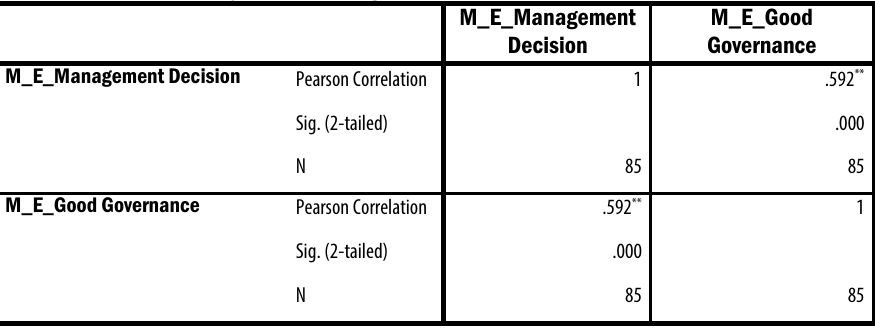
Table: 5: Correlation of M&E Management Decision and Good